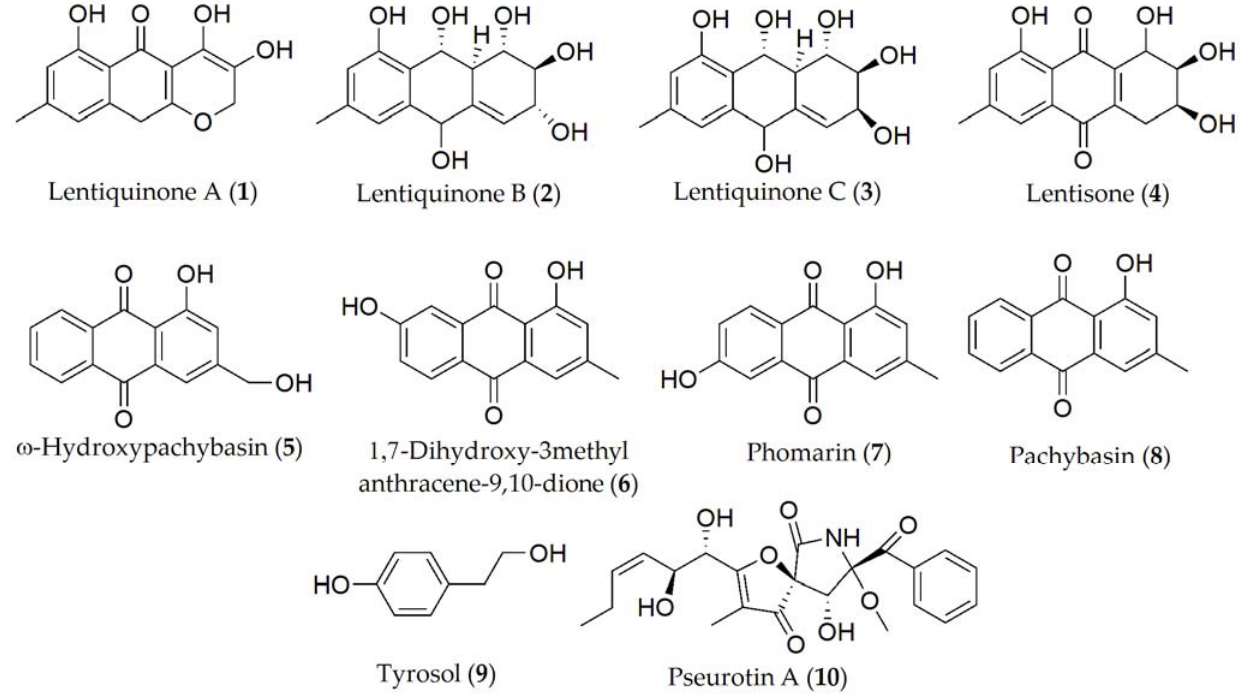
Figure 1. Phytotoxins isolated from Ascochyta lentis .